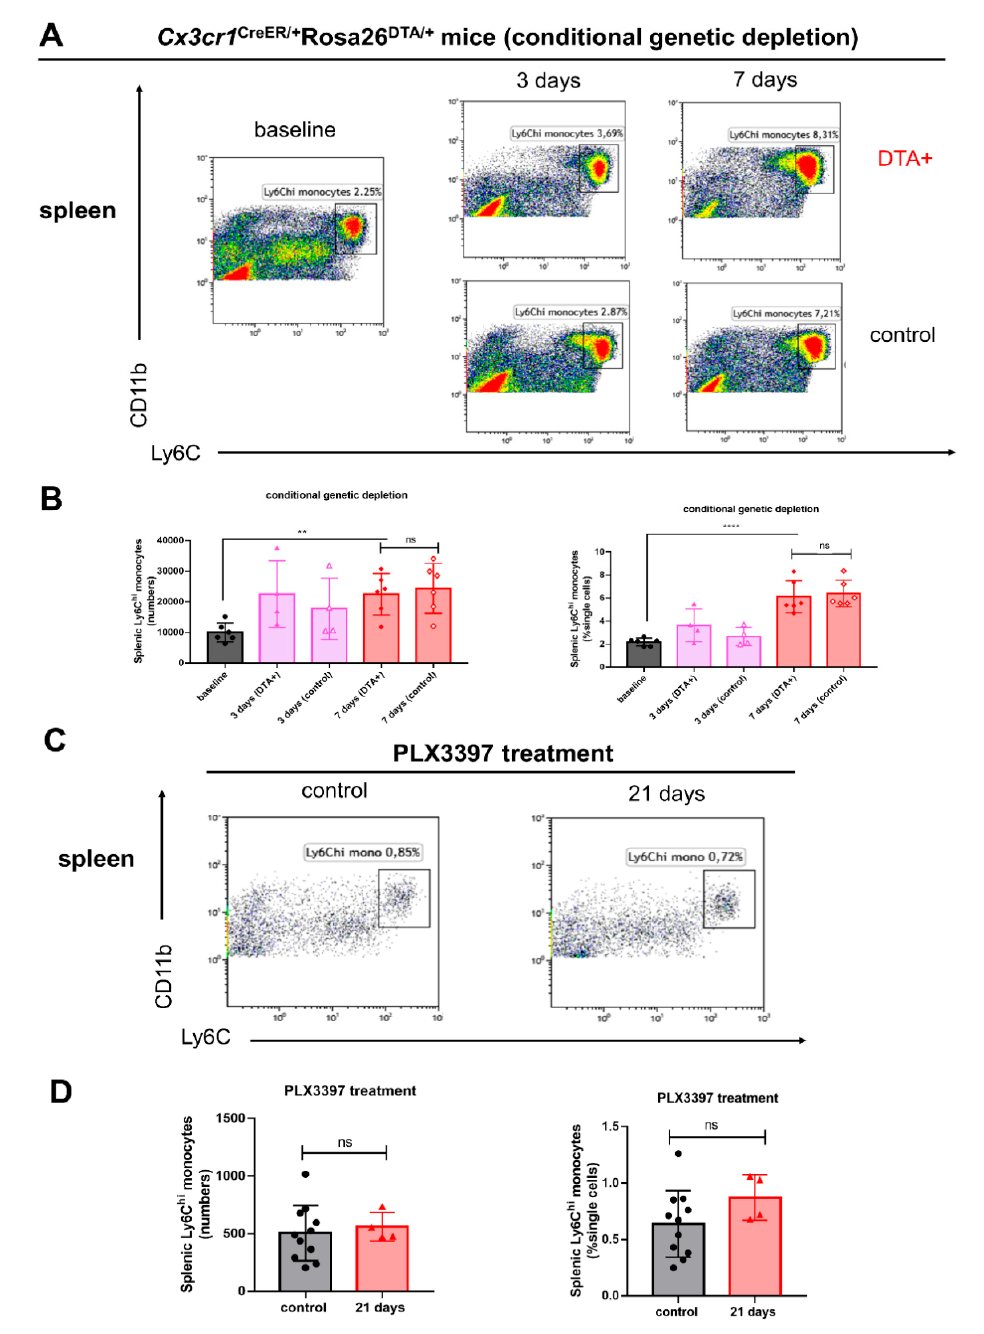
Figure 3. Splenic Ly6C hi monocytes are increased following conditional genetic microglial depletion, but not after pharmacological depletion. ( A ) Representative flow cytometry plots of CD11b + Ly6G − Ly6C hi splenic monocytes in Cx3cr1 CreER /+ Rosa26 DTA /+ and Cx3cr1 CreER /+ mice at days 3 and 7 post tamoxifen injections. ( B ) The numbers and percentages of splenic Ly6C hi monocytes ( ± SEM) in the spleen during conditional genetic microglial depletion periods (baseline, black bars; day 3, pink bars; day 7, red bars, n = 6, 4, 4, 6, 6, respectively). ( C ) Representative flow cytometry plots of splenic Ly6C hi monocytes in C57BL / 6NTac mice following PLX3397 diet (21 days) at a dose of 290 mg / kg. Control mice were treated with normal diet. ( D ) The numbers and percentages of splenic Ly6C hi monocytes ( ± SEM) during pharmacological microglial depletion periods (control, black bars; day 21, red bars, n = 11, 4, respectively). Statistical significance is indicated as ** p < 0.01 and **** p < 0.0001 (ns: not significant).